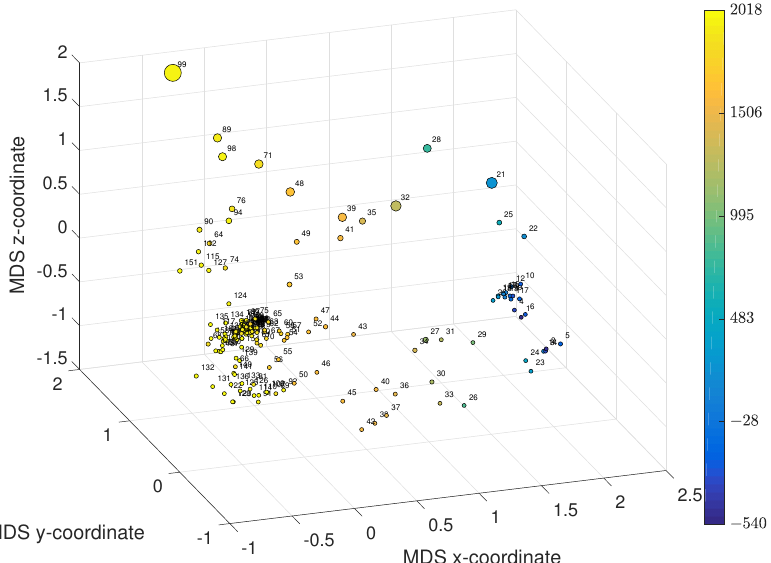
Figure 7. The 3-dimensional MDS loci obtained with the generalized distance, d 10 . The spheres represent wars, with size proportional to the number of casualties and color proportional to